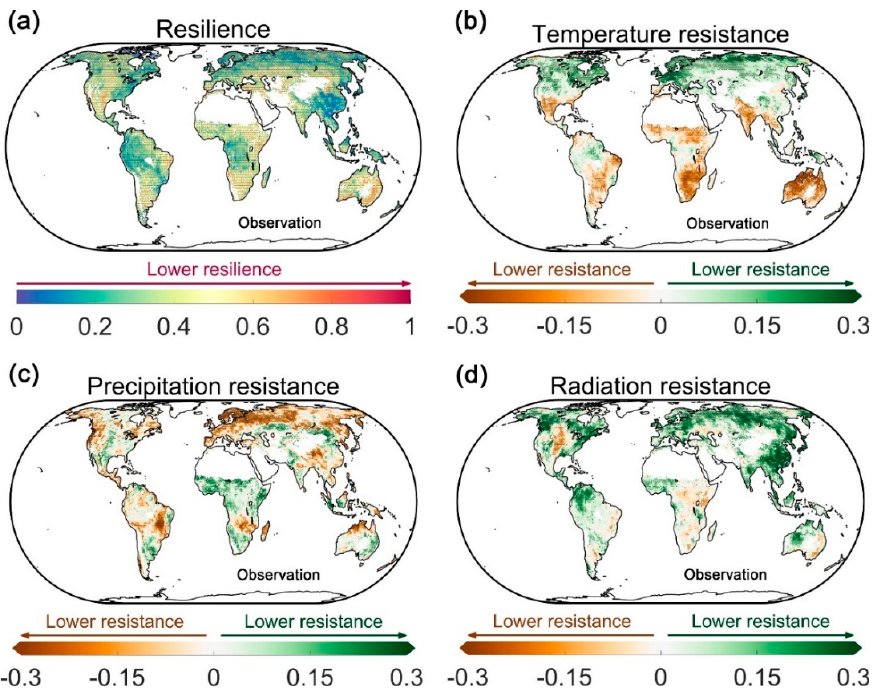
Figure 2. Spatial patterns of vegetation resilience and resistance to climatic variables based on GIMMS LAI: ( a ) vegetation resilience; ( b ) temperature resistance; ( c ) precipitation resistance; ( d ) radiation resistance. In each subfigure, stippling indicates that the vegetation resilience or climatic resistance is significant ( p < 0.05) in the grid. Vegetation resilience is within the range of 0 and 1, and larger values suggest lower resilience. Climatic resistance is within the range of − 1 and 1, and values with larger absolute magnitudes indicate lower climatic resistance.